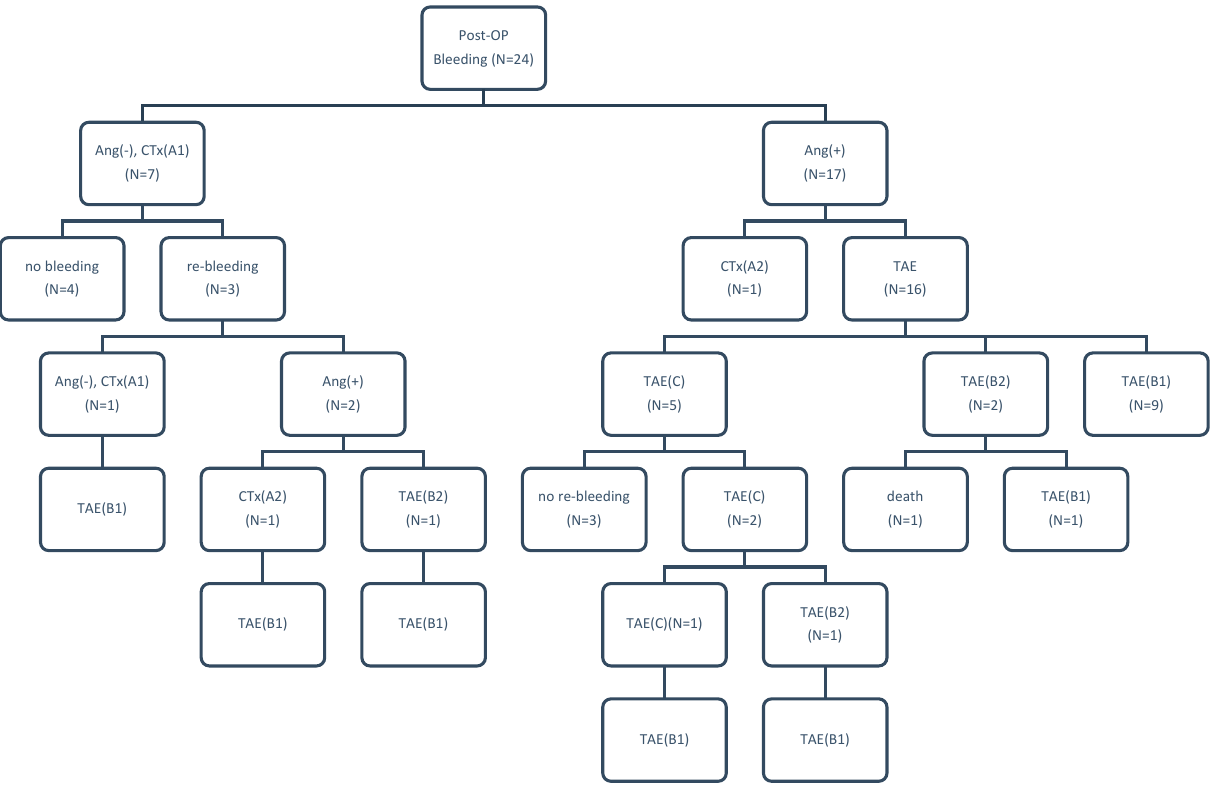
Figure 3. Flow chart representing 24 patients with postoperative hemorrhage after pancreatoduodenectomy (n = patient number). CTx, conservative treatment; Ang(+/ − ), positive or negative angiographic findings; B1, subgroup B1; B2, subgroup B2; C, group C.